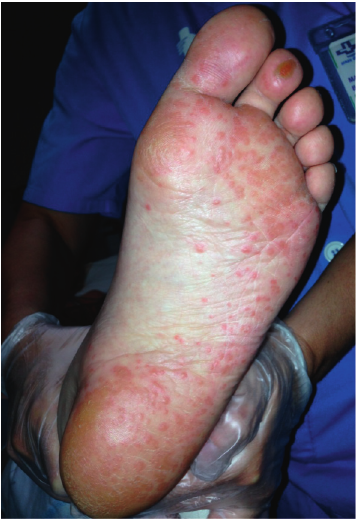
Figure 6: Secondary syphilis: maculopapular lesions on bottom of the